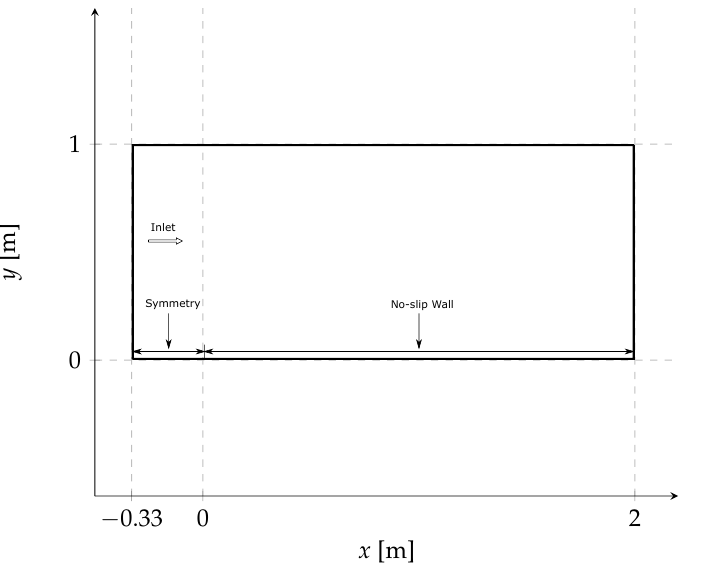
Figure 8. Schematic showing the flat plate domain.